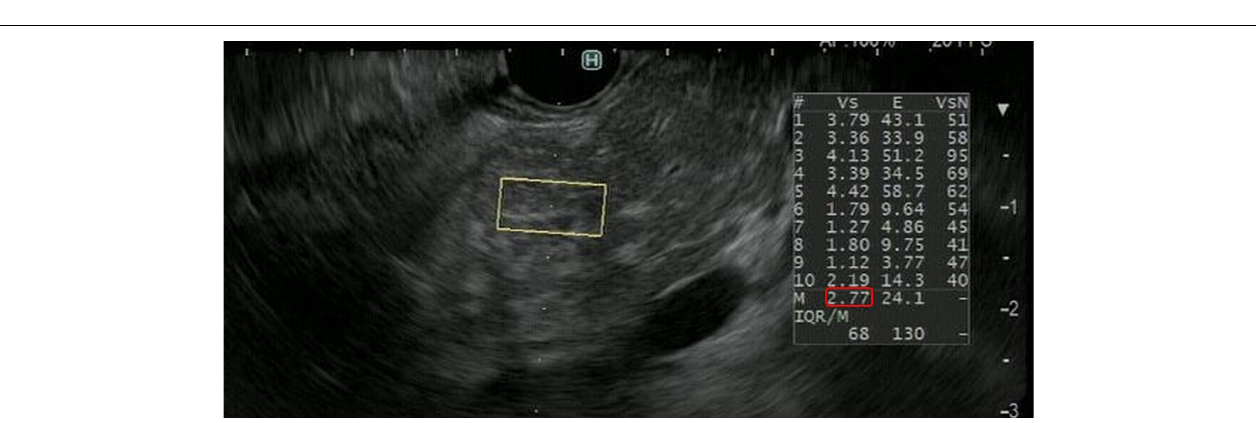
FIGURE 5 | Representative EUS shear wave elastography (EUS-SWE) images in a patient with chronic pancreatitis. EUS-SWE was performed to diagnose chronic pancreatitis. The shear wave velocity (distance/arrival time lag [Vs, m/s]) value of 2.77 (displayed in red square) for the region of interest (yellow square) was higher than the cut-off Vs values of 2.19 and 1.96 for diagnosing chronic pancreatitis.